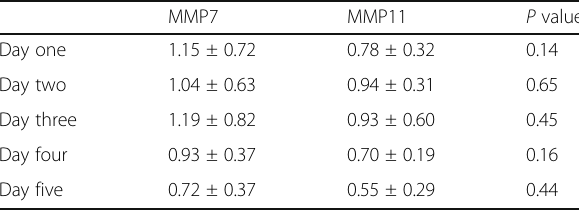
Table 5 Distribution of the mean values of MMP7 and MMP11 through different days of